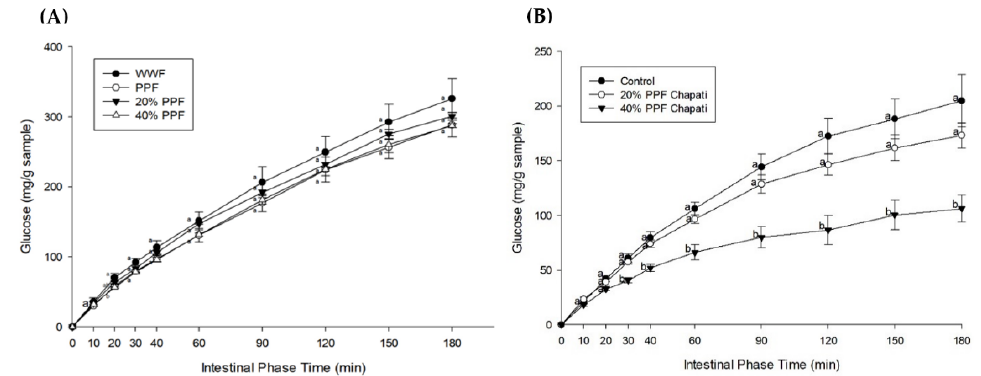
Figure 1. The effects of pigeon pea flour (PPF) and its partial substitution for whole wheat flour (WWF) on glucose release. The glucose profiles of ( A ) flour samples and ( B ) chapati samples. Different superscript letters for the same time interval denote statistically significant differences in the mean values among the groups at p < 0.05 ( n = 3). 20% PPF: 20% pigeon pea flour substitution; 40% PPF: 40% pigeon pea flour substitution.